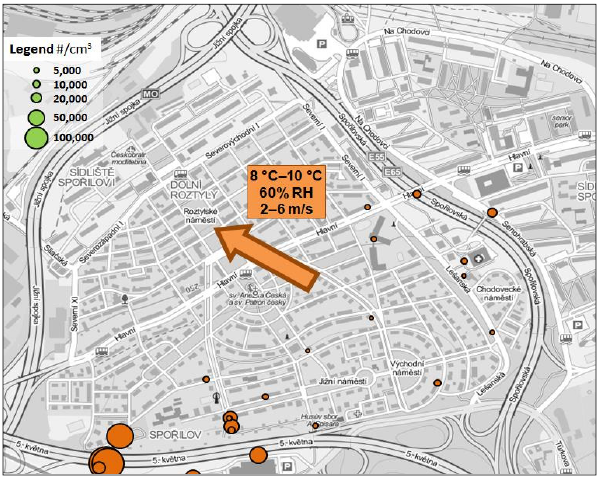
Figure 10. Measured average UFP concentrations near a hotspot and around in Sporilov on 26 March; High concentrations measured on a footbridge over a freeway were a result of emissions from truck accelerations after extended periods of heavy congestion. Impact